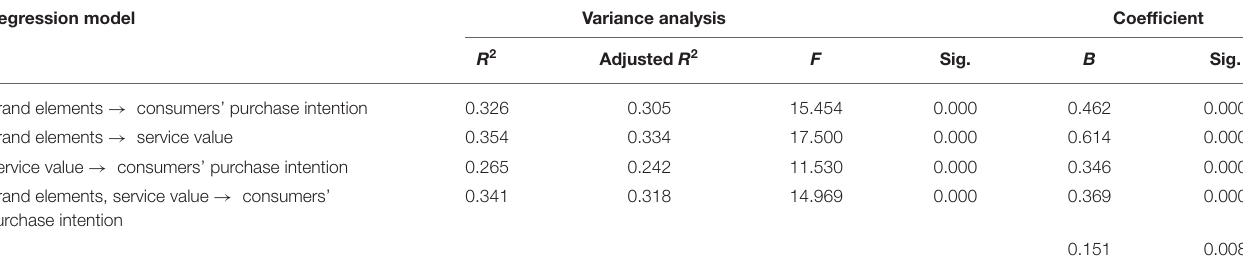
TABLE 14 | Intermediary role played by the service value. Regression